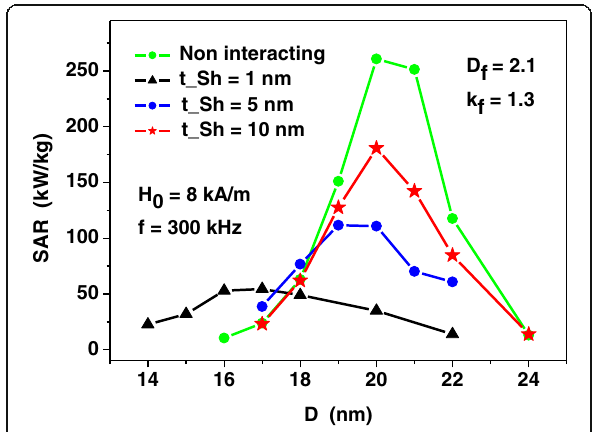
Fig. 5 The dependence of the SAR of dilute assembly of fractal clusters on the thickness t Sh of the non-magnetic shells at the surface of the nanoparticles. The SAR of the assembly of non-interacting nanoparticles is calculated by means of Eqs. (1) and